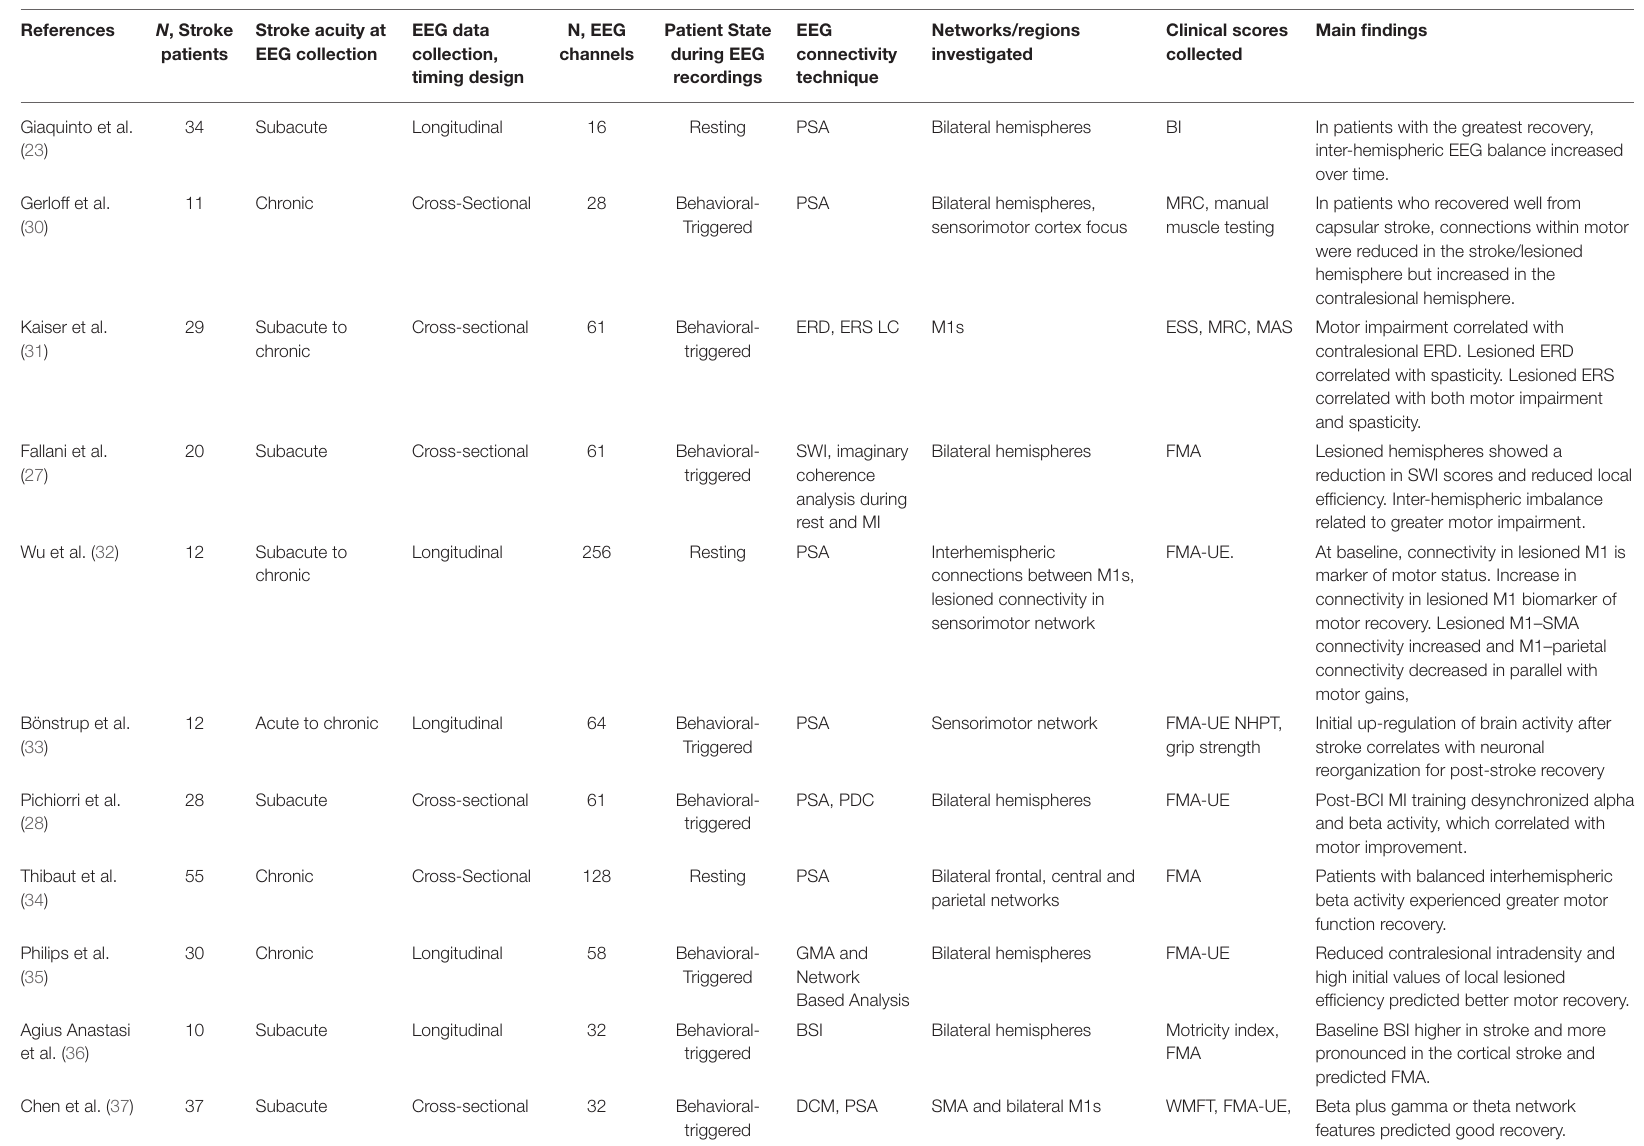
TABLE 1 | EEG studies of motor